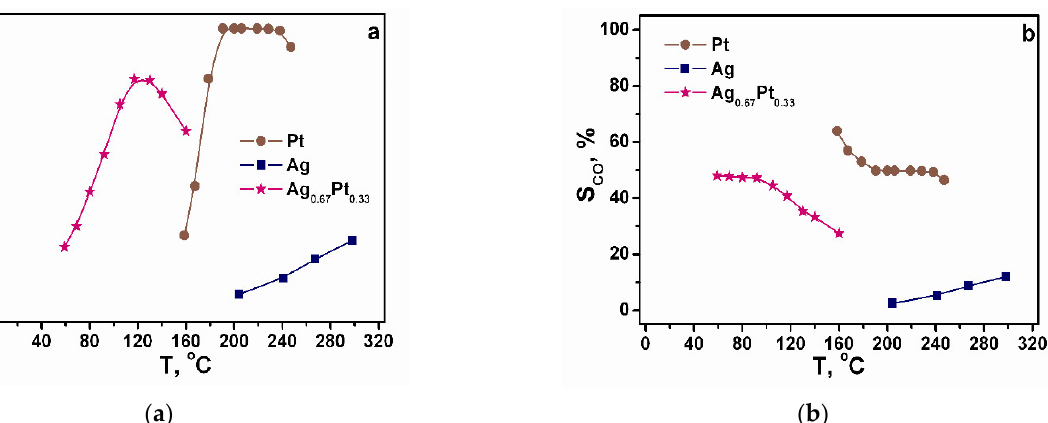
Figure 11. The temperature dependences of CO conversion (X CO ) ( a ) and selectivity (S CO ) ( b ) for CO PROX over the Pt, Ag, and Ag 0.67 Pt 0.33 nano-powders. Feed gas composition (vol.%): 1.0 CO, 1.0 O 2 with H 2 as balance. WHSV: 80 000 cm 3 g −1 h −1 (STP).